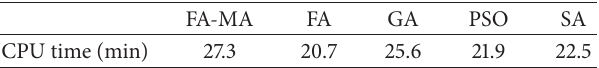
Table 6: Time consuming of SVR model with different parameter determination methods.